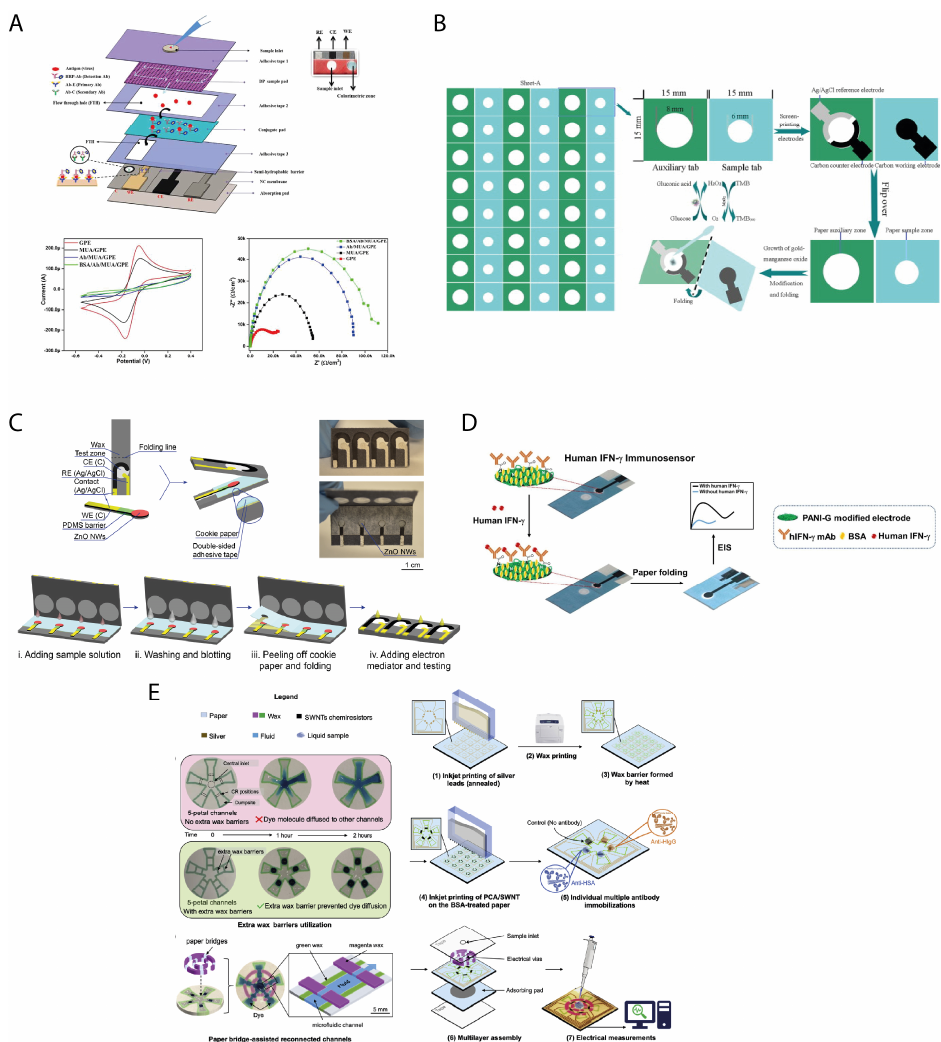
Figure 3. ( A ) Vertical flow-based paper immunosensor for rapid electrochemical and colorimetric detection of influenza virus using a different pore size sample pad. Reprinted with permission from [38], 2018 Elsevier; ( B ) growth of gold-manganese oxide nanostructures on a 3D origami de- vice for glucose-oxidase label based electrochemical immunosensor. Reprinted with permission from [40], 2014 Elsevier; ( C ) a microfluidic paper-based origami nanobiosensor for label-free, ul- trasensitive immunoassays. Reprinted with permission from [41], 2016 WILEY-VCH Verlag GmbH & Co; ( D ) label-free paper-based electrochemical impedance immunosensor for human interferon gamma detection. Reprinted with permission from [42], 2018 Elsevier; ( E ) an origami immunosensor for multiplexed analyte detection in body fluids. Reprinted with permission from [44], 2020 Elsevier.